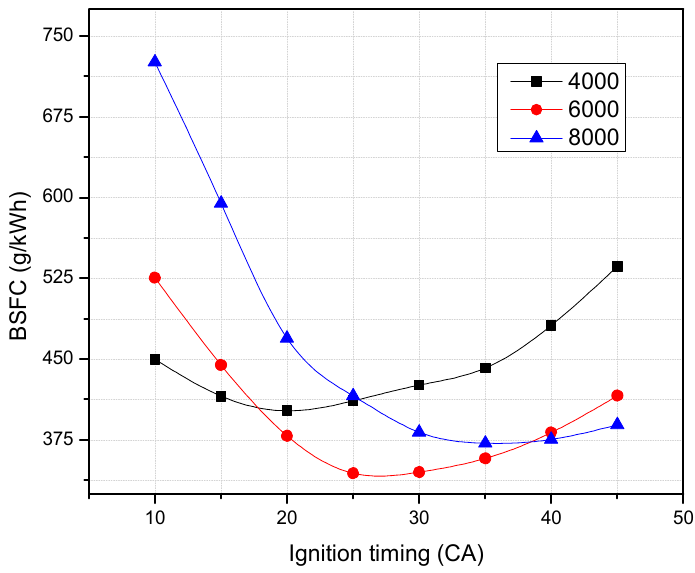
Figure 15. BSFC versus ignition timing.